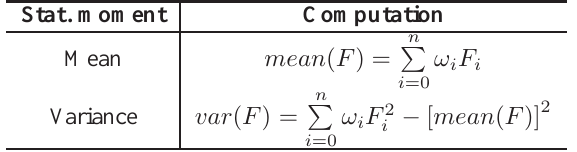
Table 2: UT/SC computation of statistical moments (1st and 2nd) for the 1-RV